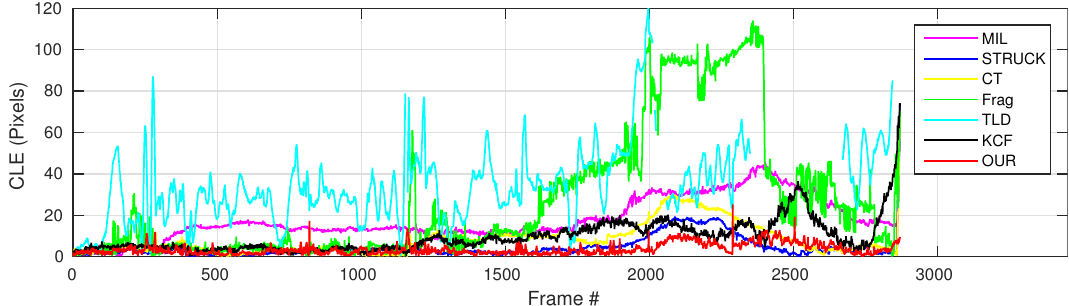
Figure 6. Center location error (CLE) error evolution plot of all visual trackers with the container image sequence.